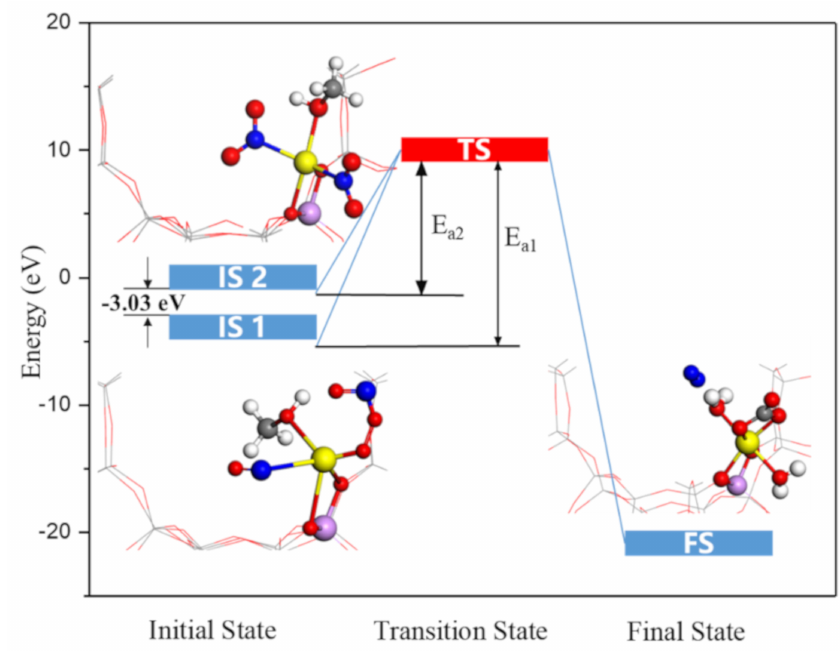
Figure 10. Energy profile of the reactants (NO or NO 2 ), undetermined transitional state, and the products (N 2 , H 2 O and H 2 O).